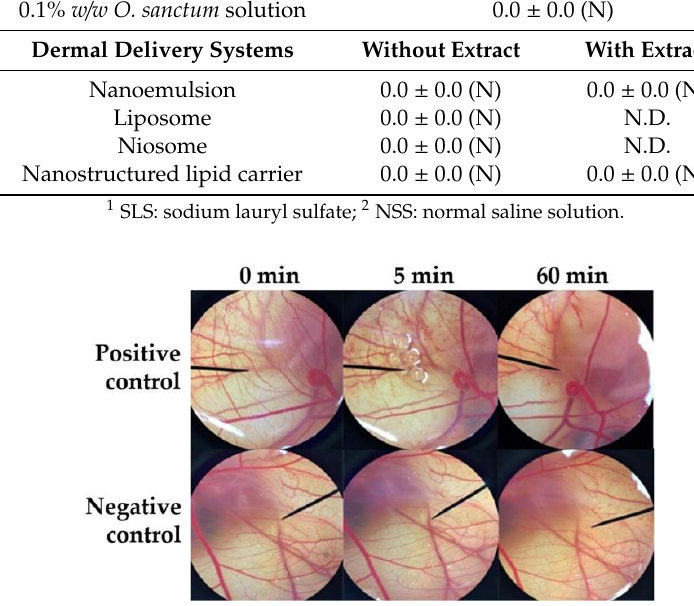
Figure 7. Photograph illustrating the effect of positive control (1% w/v SLS solution) and negative control (0.9% w/v NaCl) on chorioallantoic membrane before exposure the sample (0 min), after 5 min, and at the end of the experiment of 60 min.